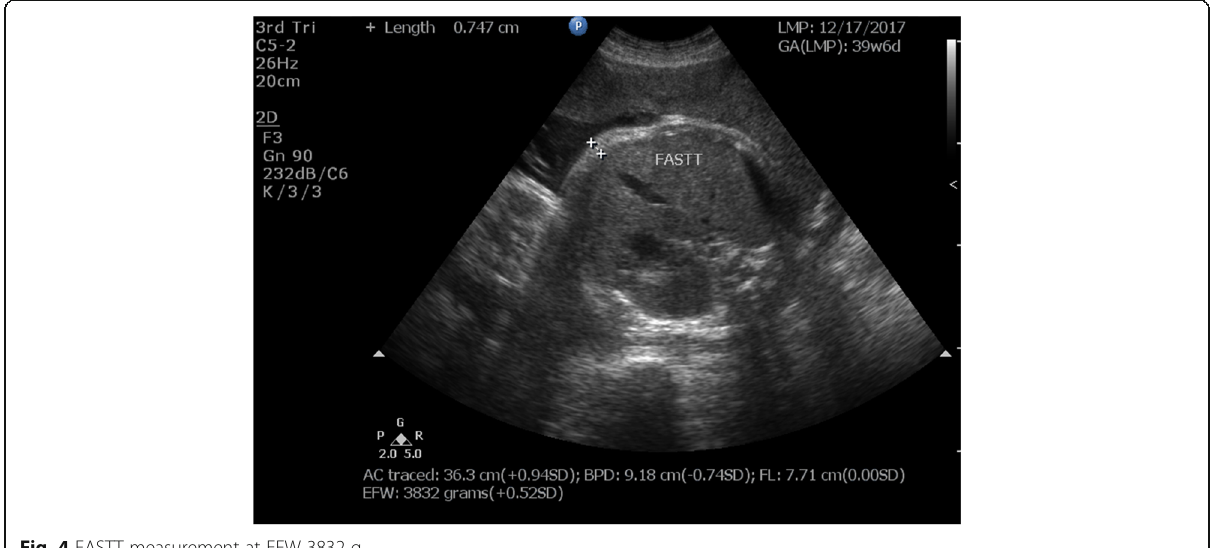
Fig. 4 FASTT measurement at EFW 3832 g